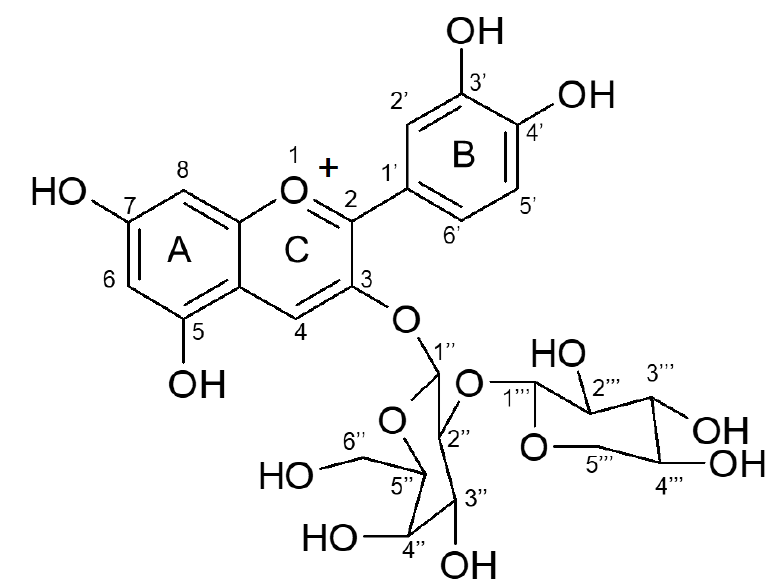
Figure 5. Chemical structure of cyanidin 3-xylosyl-galactoside based on ESI-MS, 13 C, and 1 H analyses. In addition, the molar absorptivity ( ε ) of Cya-3-Xyl-Gal (MW = 583) was determined and calculated to be 16,900 L/(mol·cm) from the slope of the plot between λ max (530 nm) over a concentration range of 0 – 0.05 mmol/L.